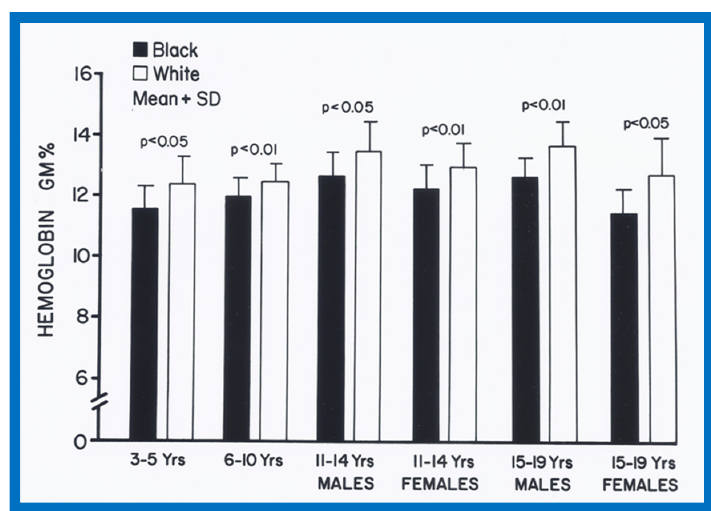
Figure 36. Bar graph showing comparison of hemoglobin, gm% in black (filled bars) and white (open bars) white children. Means and standard deviations (SD) are shown. Note the significantly lower ( p < 0.05 to < 0.01) hemoglobin values in black than white children for all age-gender subgroups. Reproduced from Rao P.S., Thapar M.K. [10].